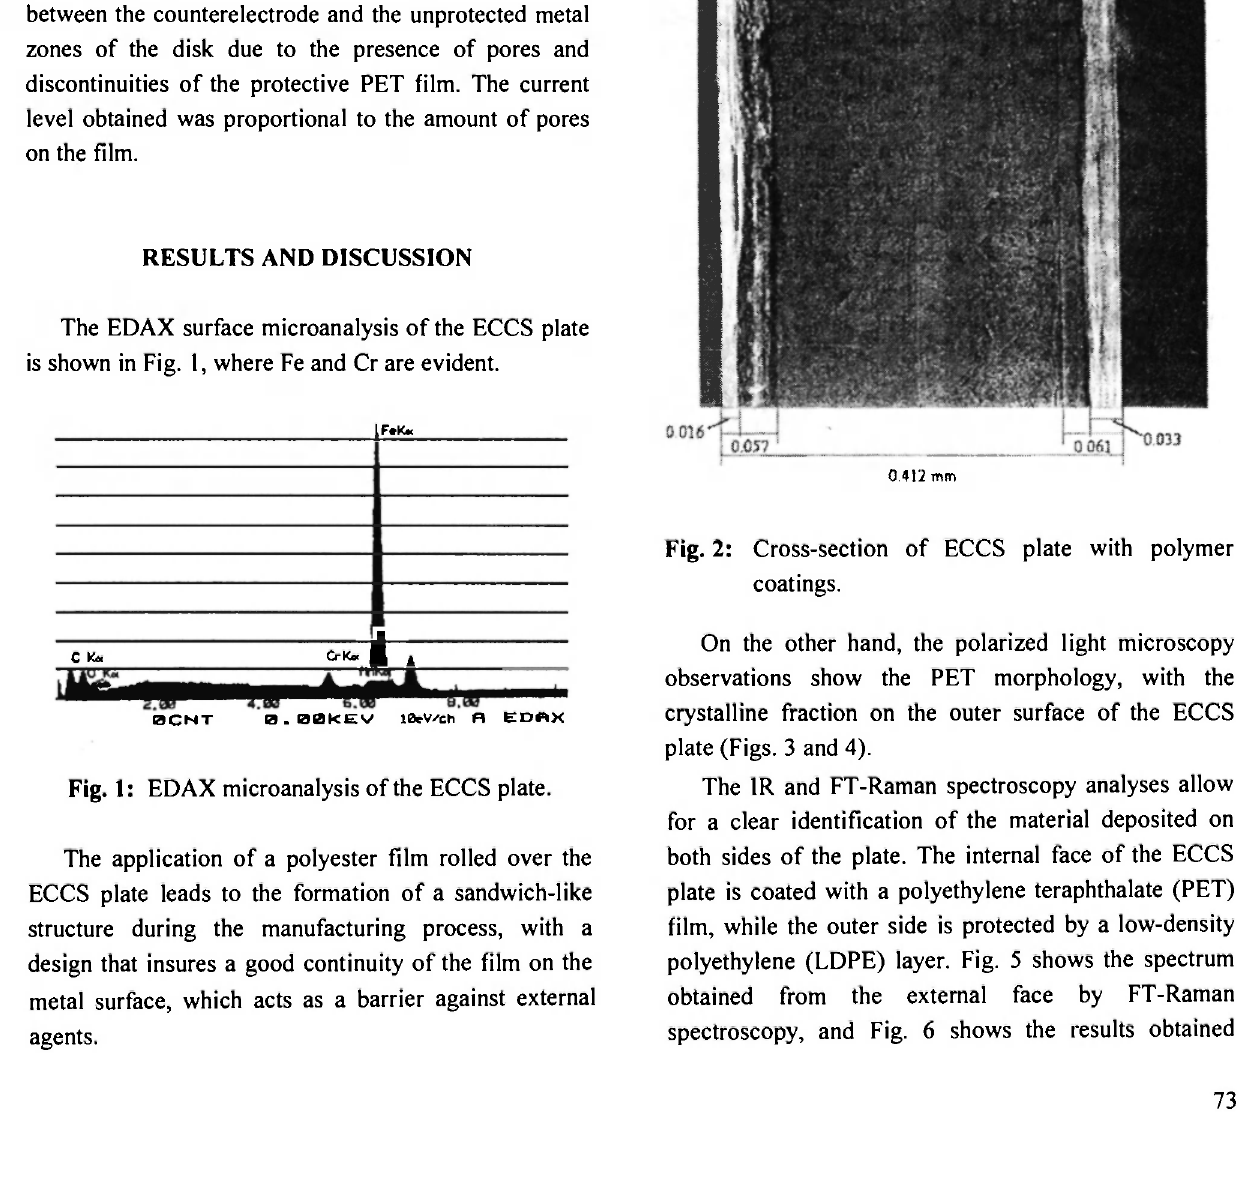
Fig. 2: Cross-section of ECCS plate with polymer